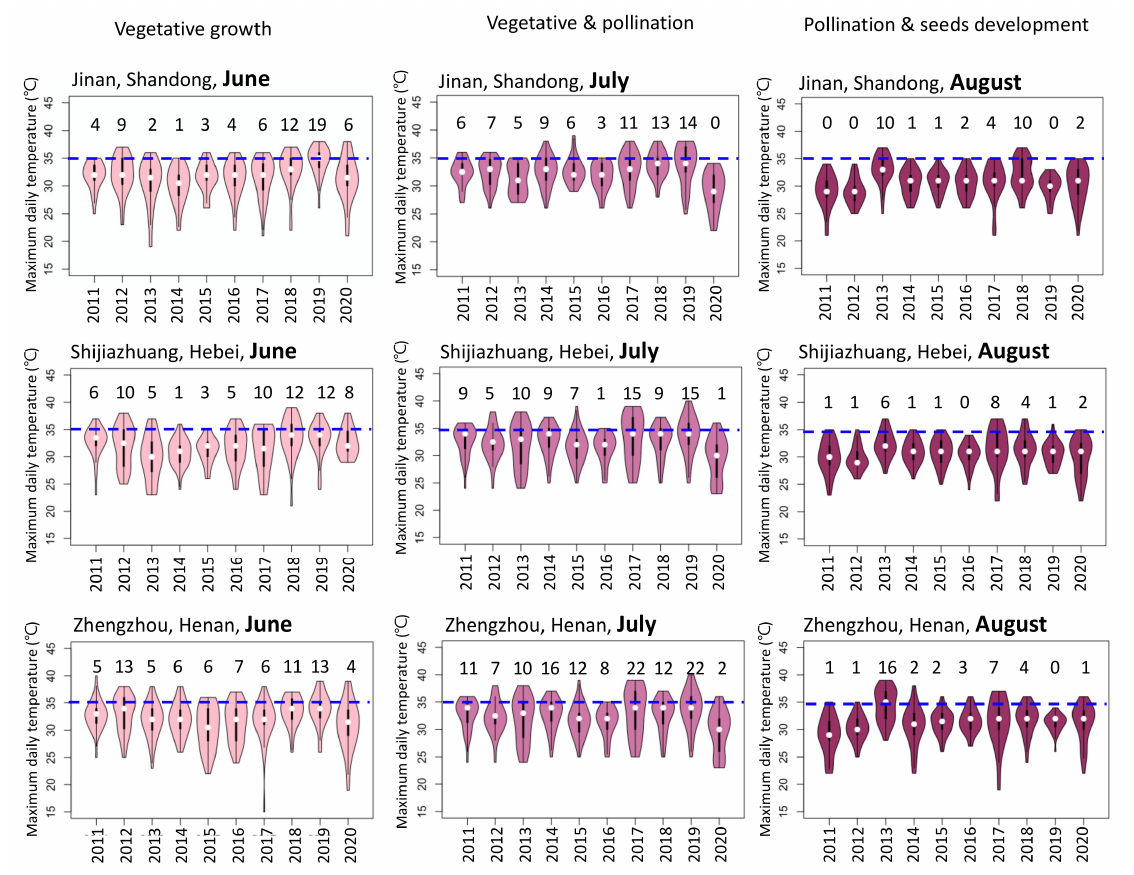
Figure 2. The maximum temperature during maize vegetative growth and reproduction (June, July, and August) in three cities in the Huang-Huai-Hai maize production region of China. The blue lines represent 35 ◦ C, and the numbers represent the numbers of days above 35 ◦ C in that month. Violin plots were generated for the temperatures during 2011–2020. Historical temperatures for the three cities were sourced from http://tianqi.2345.com (accessed on 18 January 2022). See legend in Figure 1c for the explanation of violin plots